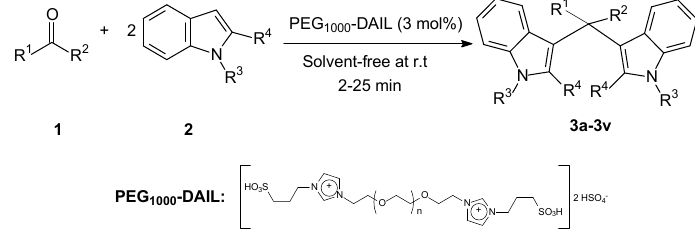
Table 1. Optimizing reaction conditions.